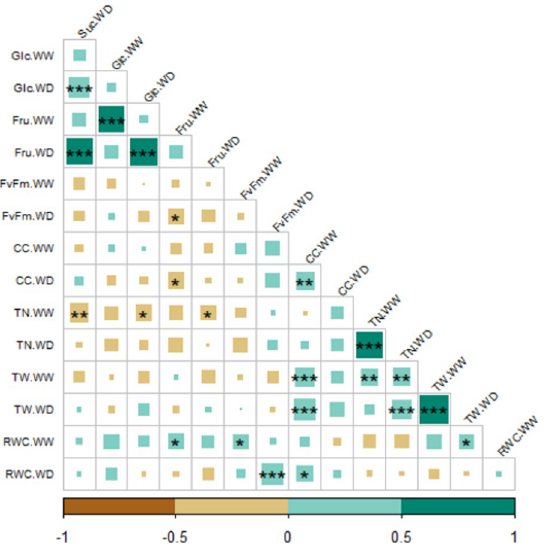
Fig 2. Spearman’s correlation matrix between physiological, biochemical and yield-related variables. The color and size squares represent the correlation between pairwise comparisons. � significant at p < 0.05 level, �� significant at < 0.01 level, ��� significant at < 0.001 level, blank for